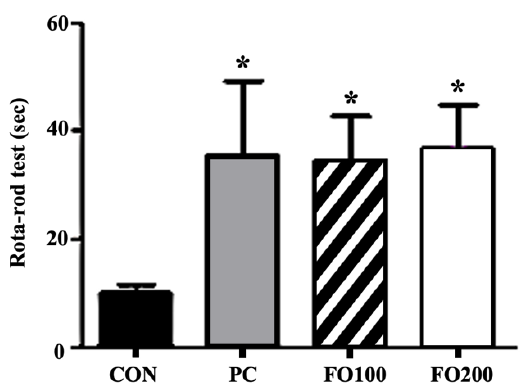
Figure 8. Exercise endurance was measured as the total time sustained on the gyratory rod. Differences in total time were recorded following administration of 100 and 200 μg/mL of FO. Each bar represents the mean ± SD. A one-way ANOVA test was carried out to determine significant differences (* p < 0.05 vs. Control).